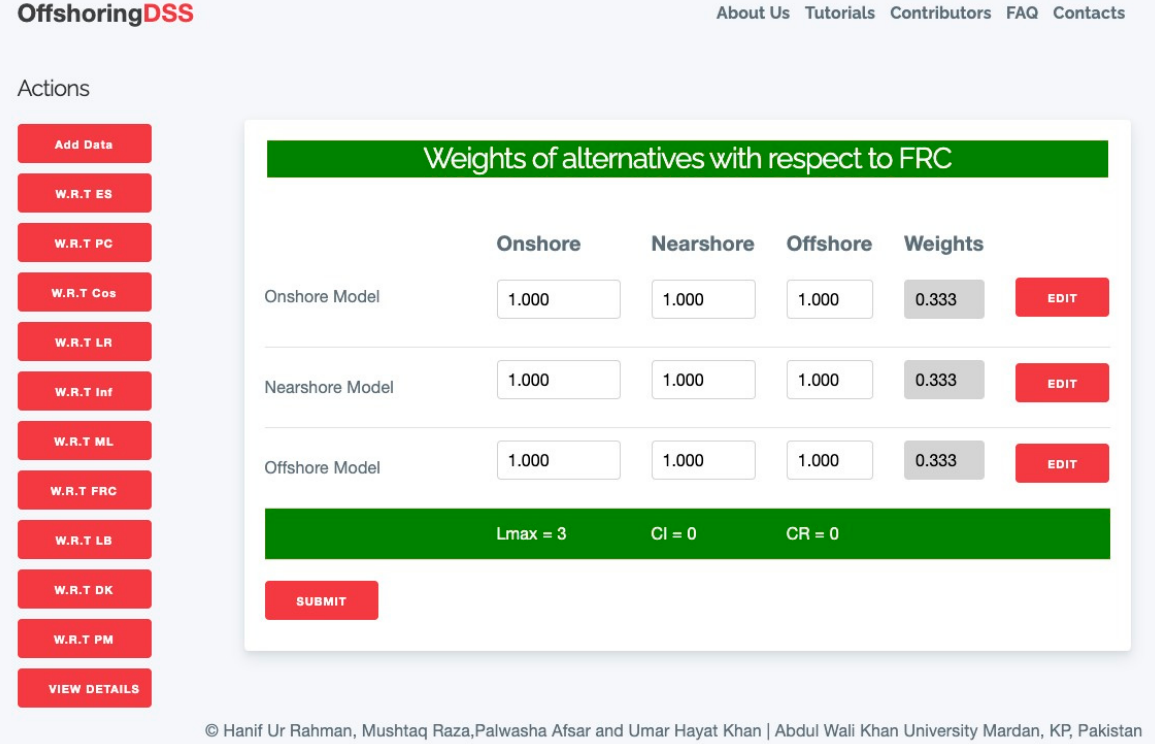
Figure A6. Alternatives weights with reference to FRC and CR.